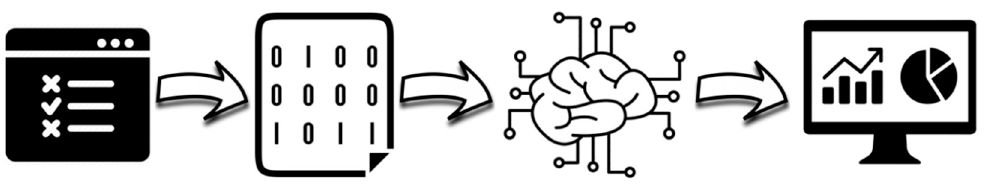
Figure 5. Integrated information flow.